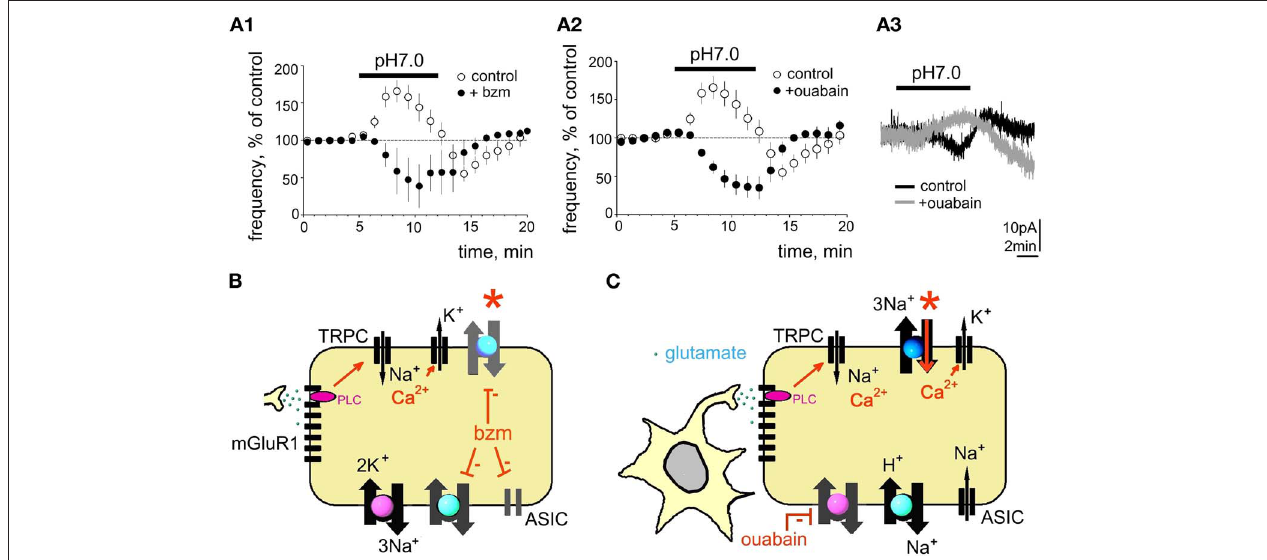
Na + /H + and Na + /Ca 2 + exchangers. Ouabain (C) blocks Na + /K +